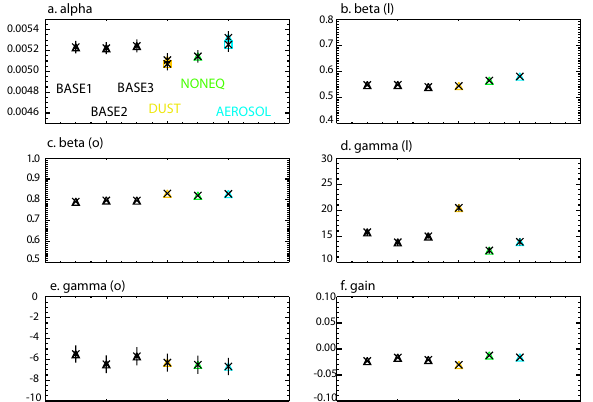
Fig. 6. Feedback parameters, alpha ( ◦ Kppm CO 2 ) − 1 (a) , beta (land) (PgCppm − 1 CO 2 ) (b) , beta (ocean) (PgCppm − 1 CO 2 ) (c) , gamma (land) (PgC ◦ K − 1 ) (d) , gamma (ocean) (PgC ◦ K − 1 ) (e) and gain (unitless) (e) from the Friedlingstein et al., 2006 simple model, described in Sect. 2.3, for the 3 ensemble members, and the cases of dust, non-equilibrium and